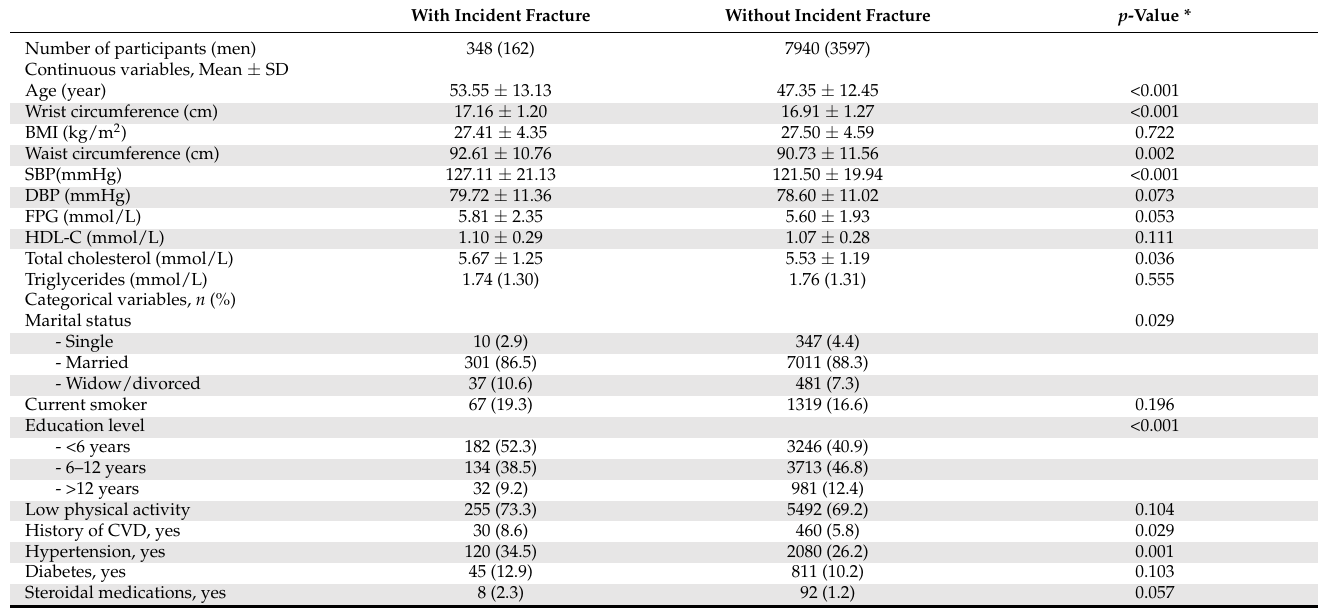
Table 2. Baseline characteristics of participants, stratified by outcome occurrence (incident fracture) during follow-up: Tehran Lipids and Glucose Study,